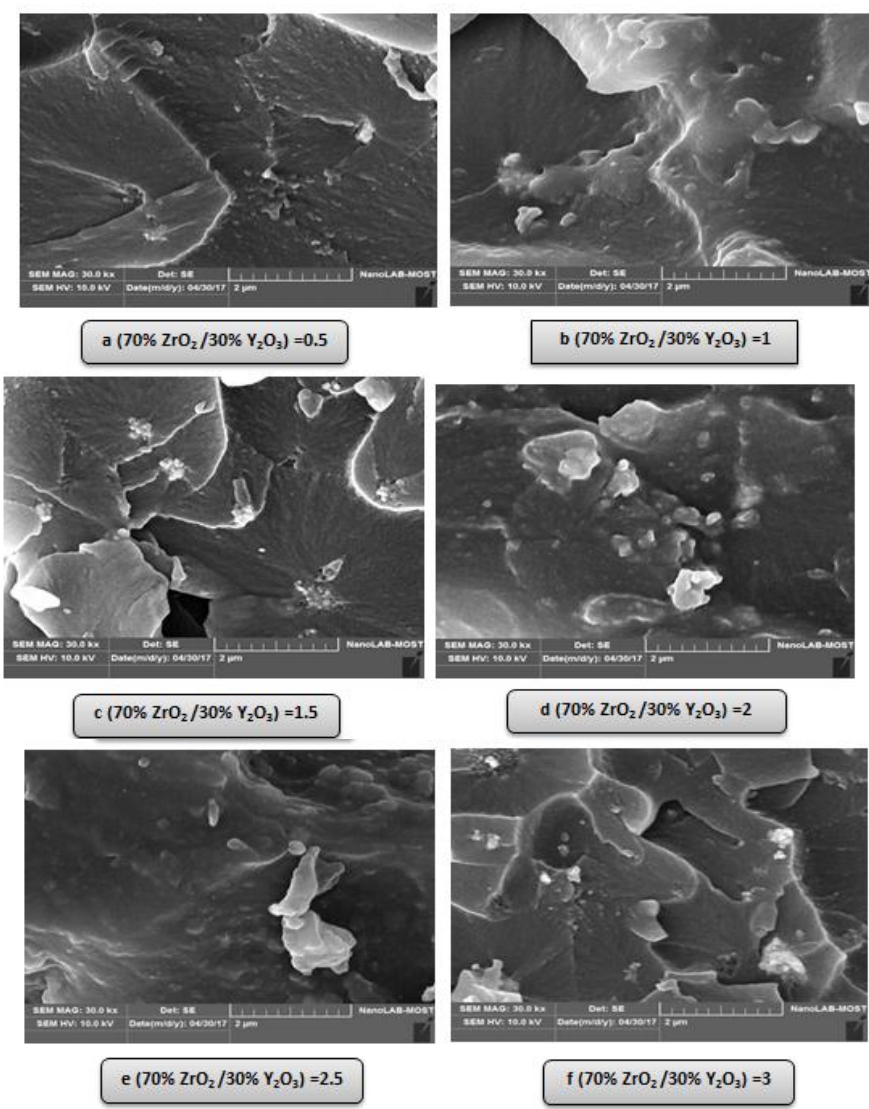
Fig. 10: SEM fracture surface morphology as a function of volume fraction of (70% ZrO + 30% Y O ) nanoparticles content in the composites, where: (a (x= 0.5%), (b (x = 1%), 2 3 (c (x= 1.5%), (d (x=2%), (e (x =2.5%) and (f (x= 3%) at the magnification of (30000